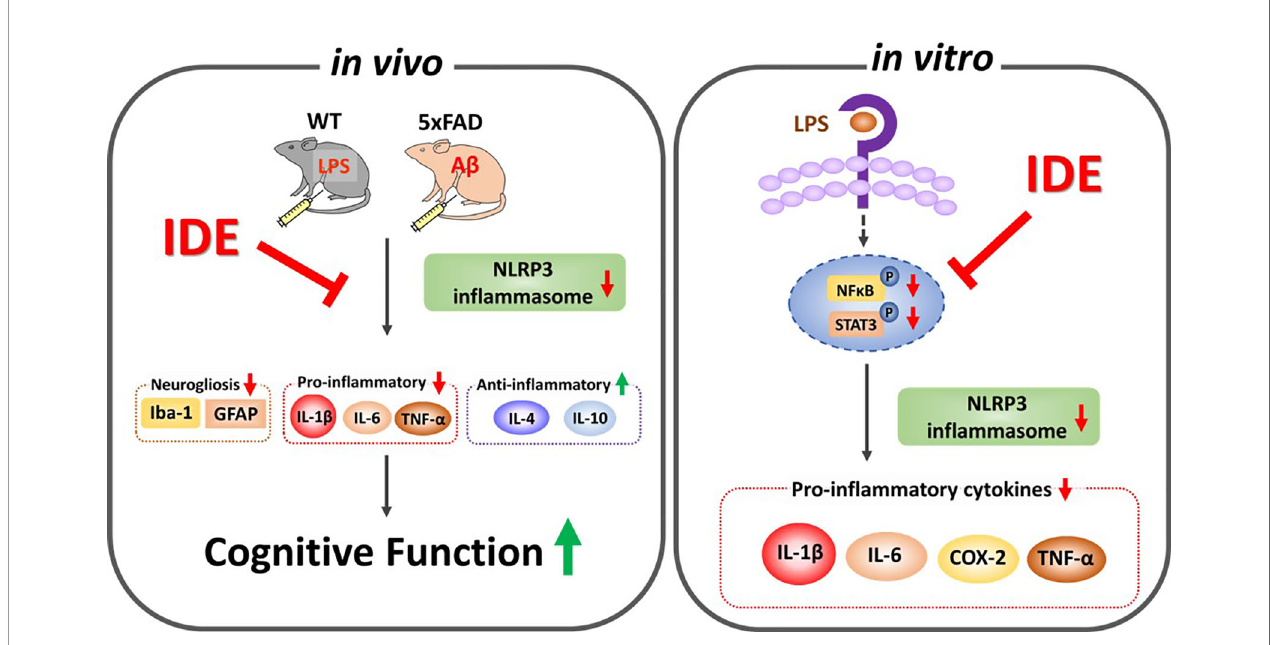
FIGURE 13 | Graphical illustration of the effects of idebenone on LPS- and A b -induced neurogliosis and memory impairments via suppression of NLRP3-IL-1 b axis. In vitro , idebenone downregulated LPS-evoked proin fl ammatory cytokine levels by inhibiting NLRP3 in fl ammasome. In vivo , idebenone decreased neurogliosis and proin fl ammatory cytokine levels by altering NLRP3 priming/activation thereby improving cognitive function in LPS-treated wild-type mice and 5xFAD